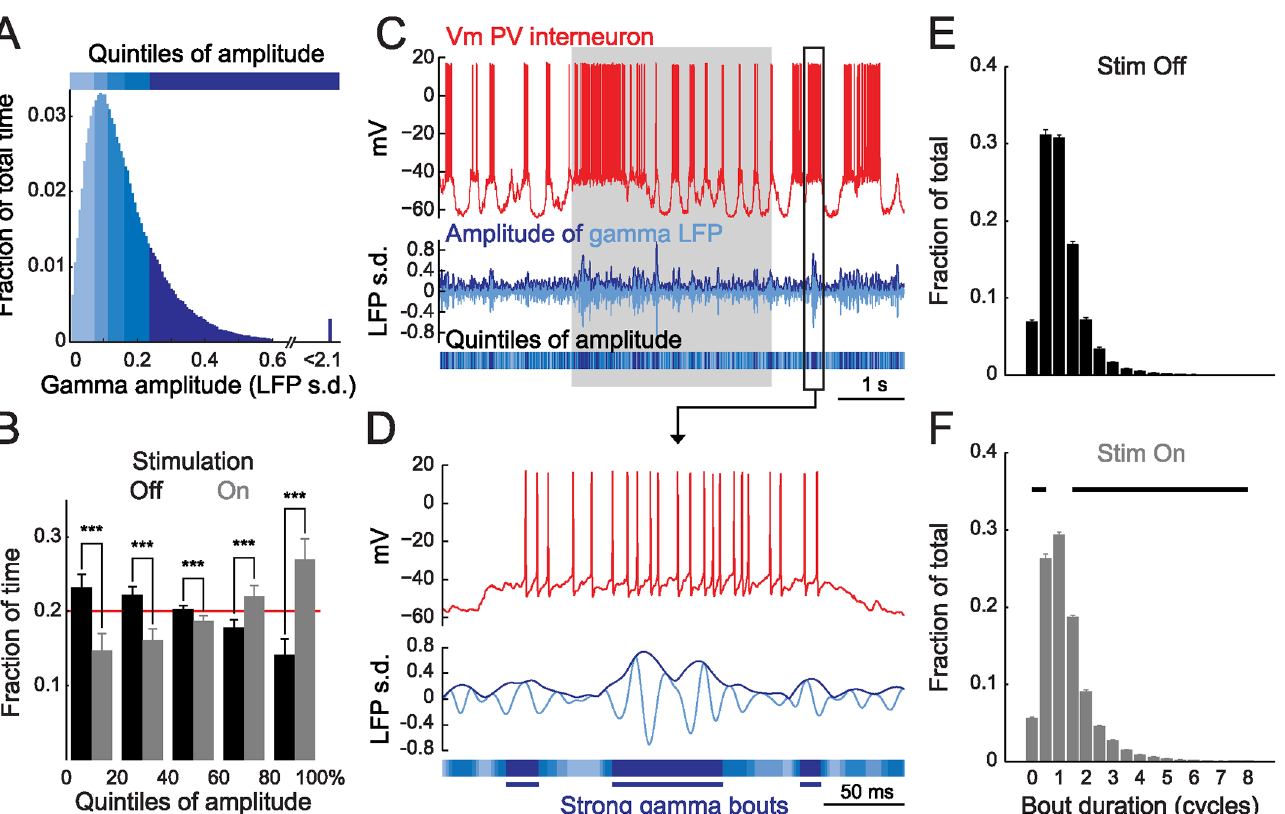
Fig 2. Gamma occurs in short bouts. ( A ) Distribution of LFP gamma amplitude over time in an example PV recording. Quintiles are color-coded from light to dark blue as a function of gamma amplitude and represent amplitude ranges occurring during one-fifth of the recording time. ( B ) Visual stimulation biases LFP gamma amplitude toward the range of strong gamma quintiles ( n = 34; red line: overall fraction of time spent in each quintile; error bars: s.e.m.; *** : p < 0.001, signed-rank test). ( C ) Example trace of the recording shown in (A) (top: whole-cell recording; middle: gamma-filtered LFP (light blue) and gamma amplitude envelope computed with the Hilbert transform (dark blue); bottom: gamma quintiles color coded as in (A); grey rectangle: visual stimulation period). ( D ) Enlargement of the portion enclosed in the black rectangle in (C) showing examples of spontaneous gamma bouts. ( E, F ) Distribution of the duration of gamma bouts outside (E, Stim Off) and during (F, Stim On) visual stimulation in gamma cycles (number hemicycles of the gamma filtered LFP divided by two; n = 34; error bars: s.e.m.; black line in (F): statistical difference between Stim Off and Stim On, FDR-corrected signed-rank test, α = 0.05).